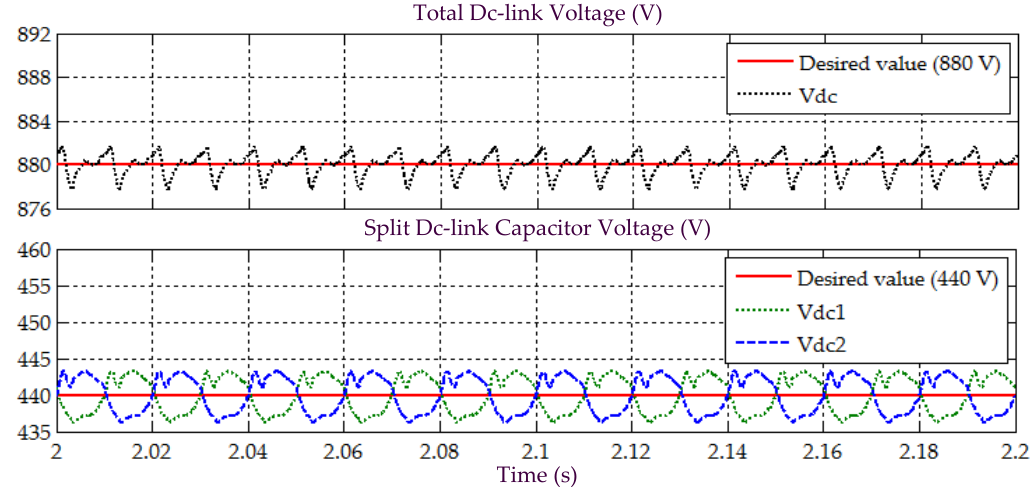
Figure 13. Simulation results obtained under Scenario B for Load 2, which include three-phase source voltage 𝑣 𝑆𝑎𝑏𝑐 , load current 𝑖 𝐿𝑎𝑏𝑐 , injection current 𝑖 𝑖𝑛𝑗𝑎𝑏𝑐 , source current 𝑖 𝑆𝑎𝑏𝑐 , and neutral current before and after mitigation, demonstrated by SAPF while applying the ( a ) proposed STF- dq 0 and ( b ) standard dq 0 techniques.